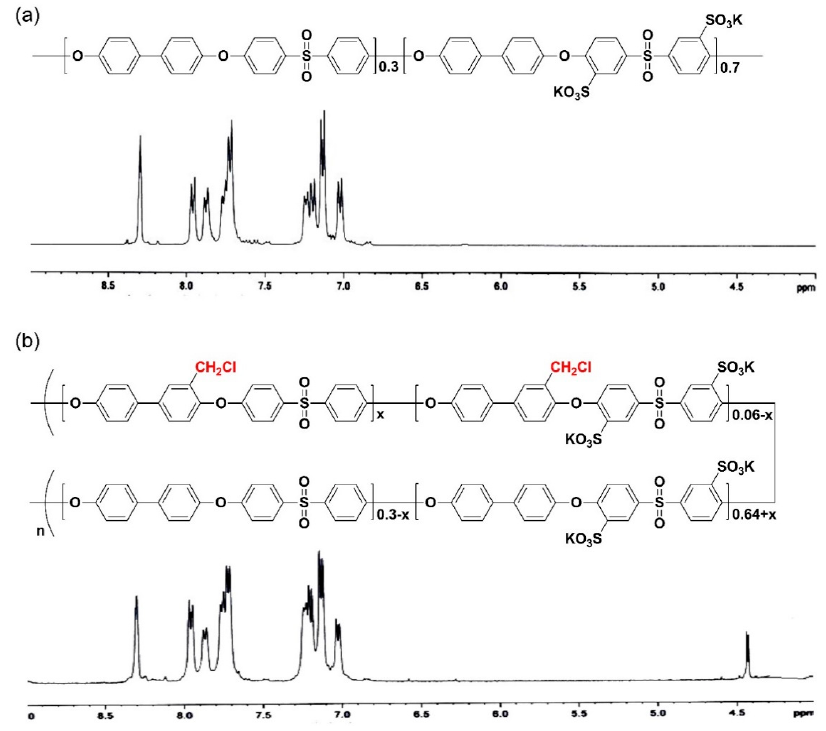
Figure 1. Chemical structures and 1 H-NMR spectra of ( a ) SPAES and ( b ) Table 1. Degree of sulfonation values and inherent viscosity of SPAES, SPAES-Cl, SDT and DT.